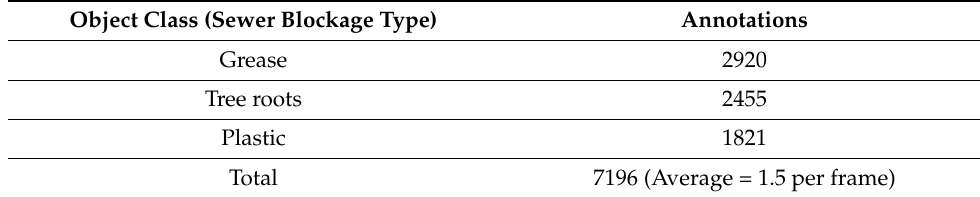
Table 3. Annotations for training data.